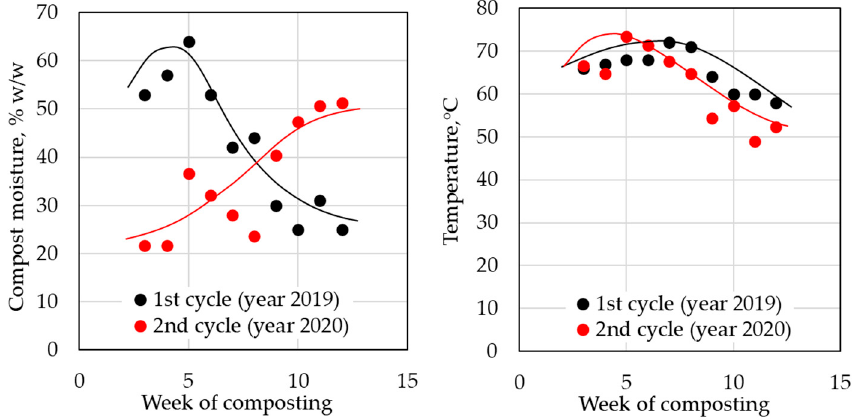
Figure 10. Moisture and temperature profiles during composting in a municipal composting plant.